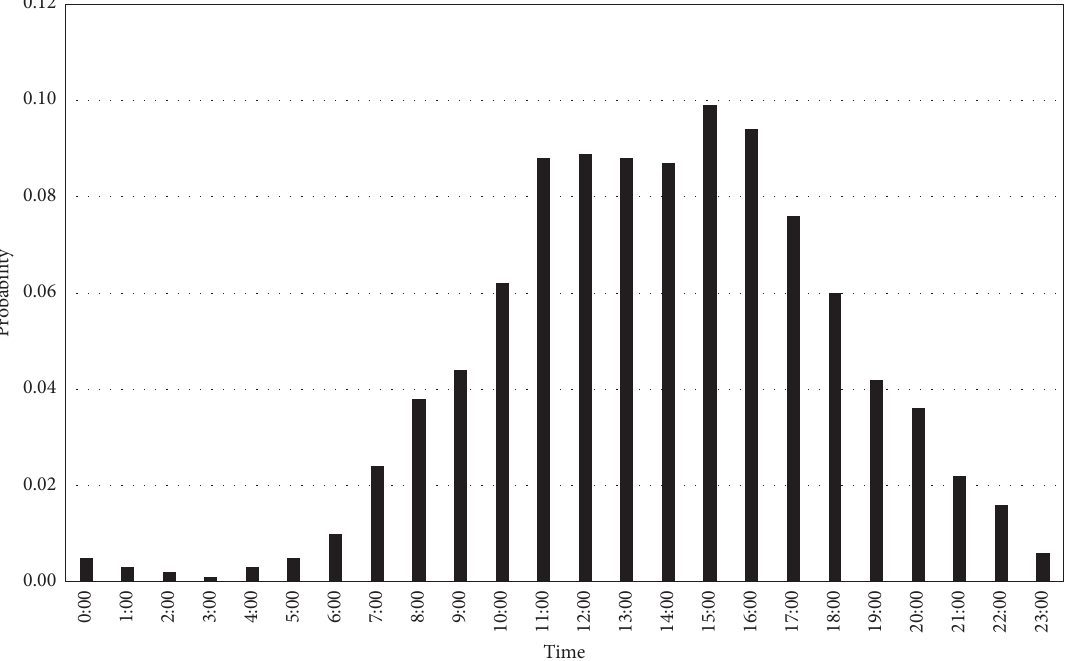
Figure 6: Probability density function of the start time of charging at public charging stations.